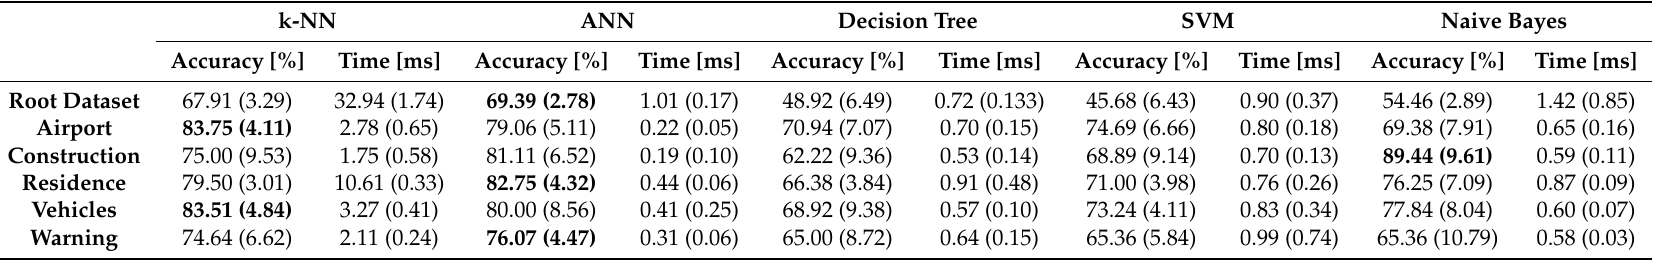
Table 10. Achievable accuracy and demanded execution time for the proposed cascade approach of the classifiers. The most accurate classifier per dataset is marked in bold. The Standard Deviation (SD) is in brackets.